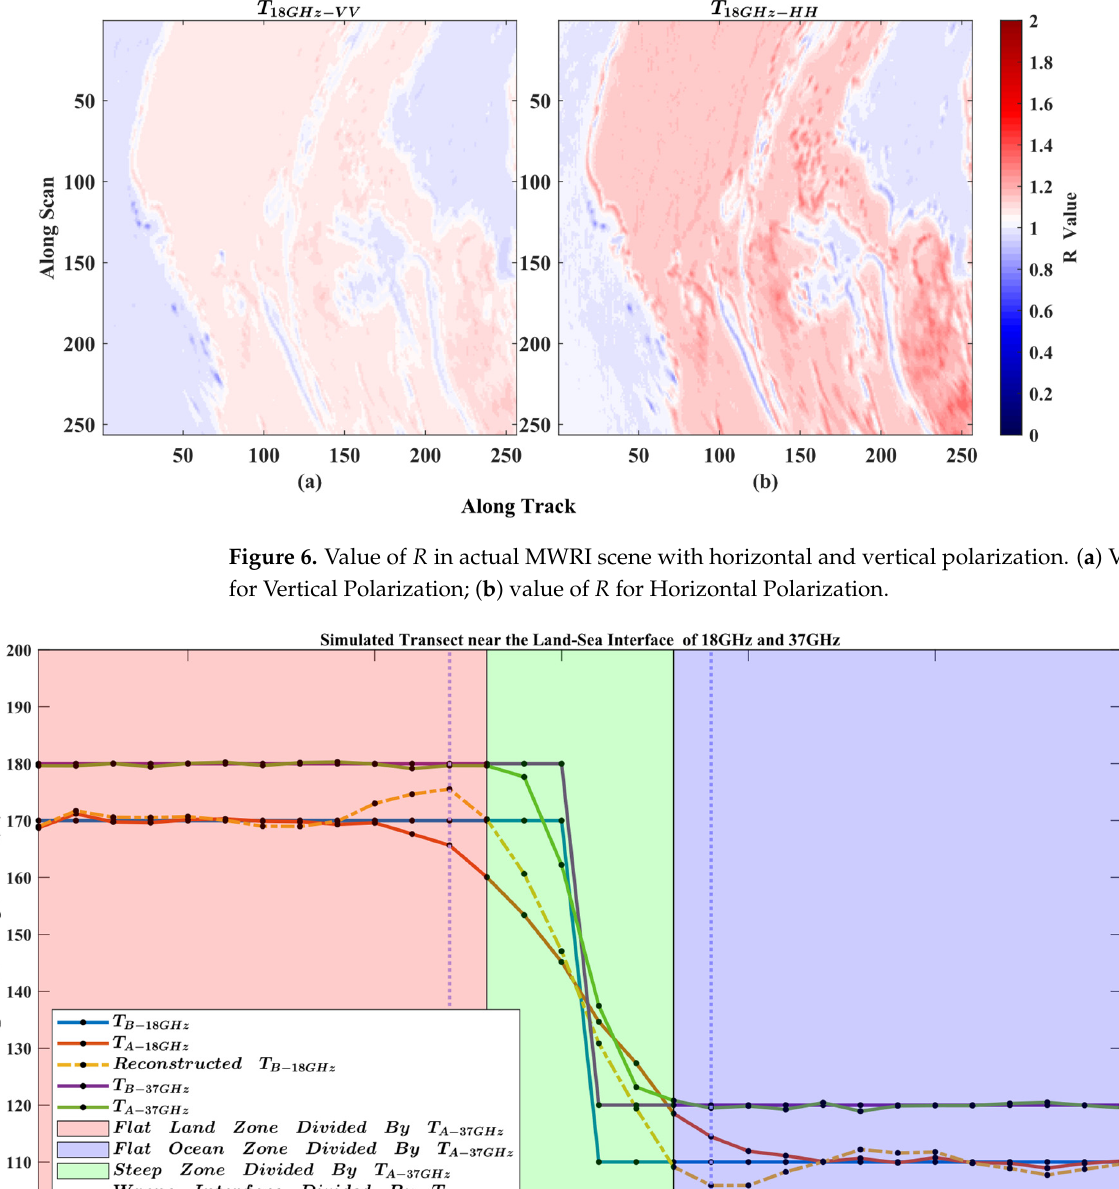
Figure 6. Value of 𝑅 in actual MWRI scene with horizontal and vertical polarization. ( a ) Value of R for Vertical Polarization; ( b ) value of R for Horizontal Polarization.